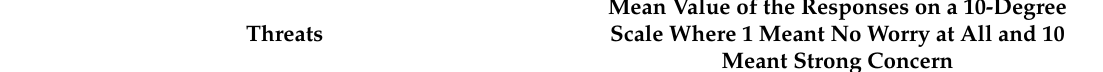
Table 2. The concern the citizens felt for di ff erent threats.